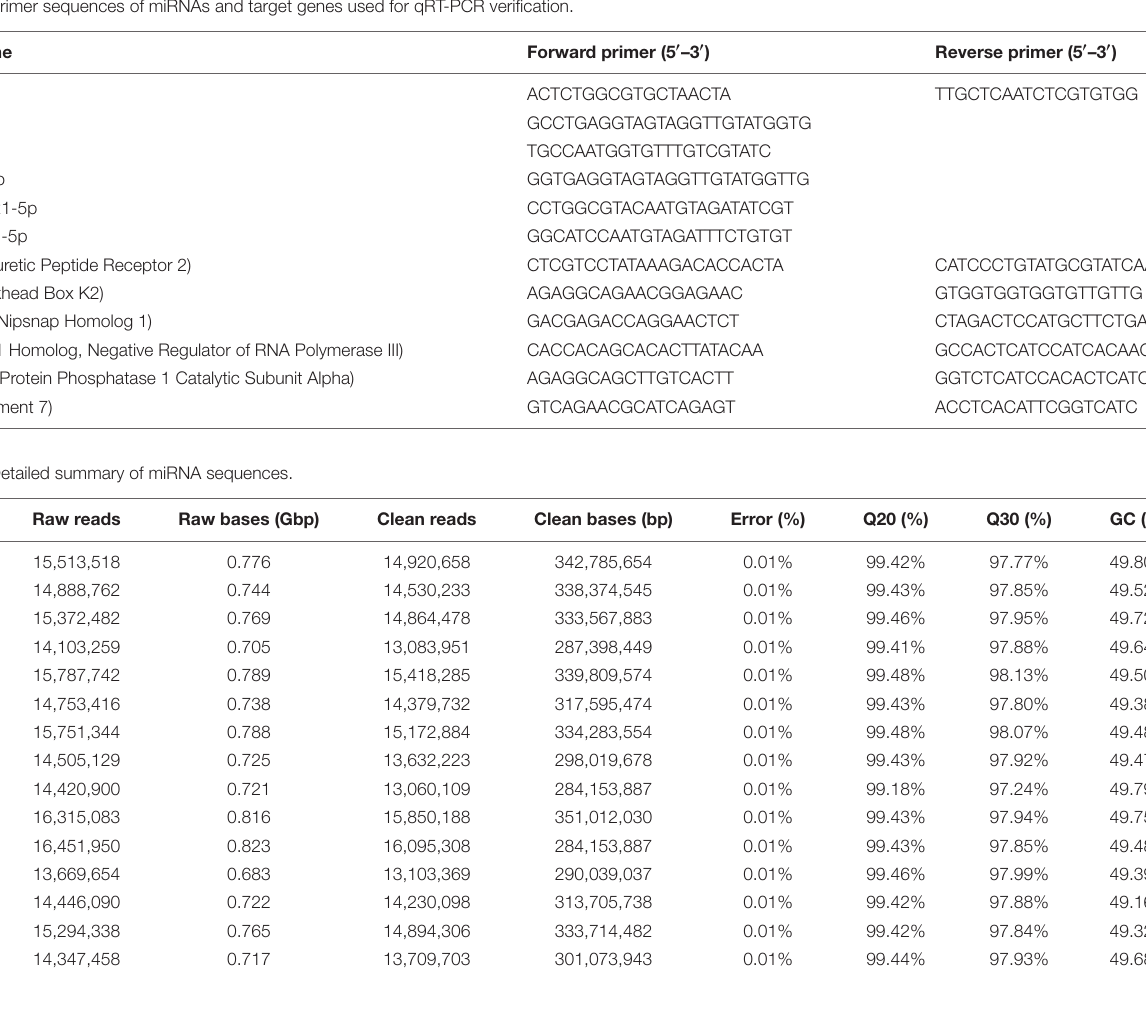
TABLE 1 | Primer sequences of miRNAs and target genes used for qRT-PCR verification.